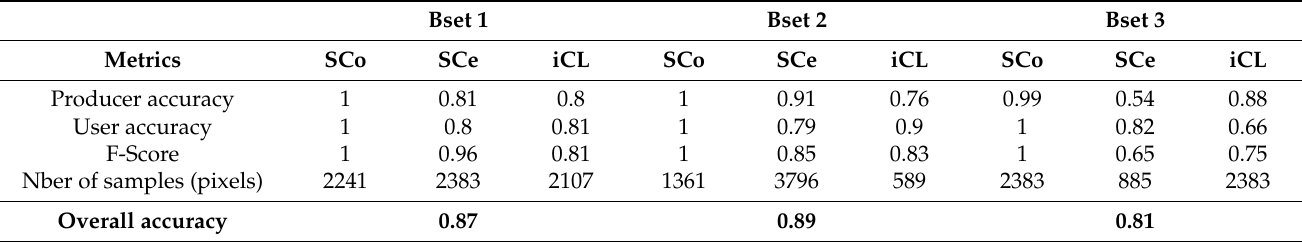
Table 2. Class accuracy metrics at Level 02, obtained with balanced (Bset1) and unbalanced (Bset2 and Bset3) training datasets. The classes are the Soybean+Cotton (SCo), Soybean+Cereals (SCe) and integrated systems